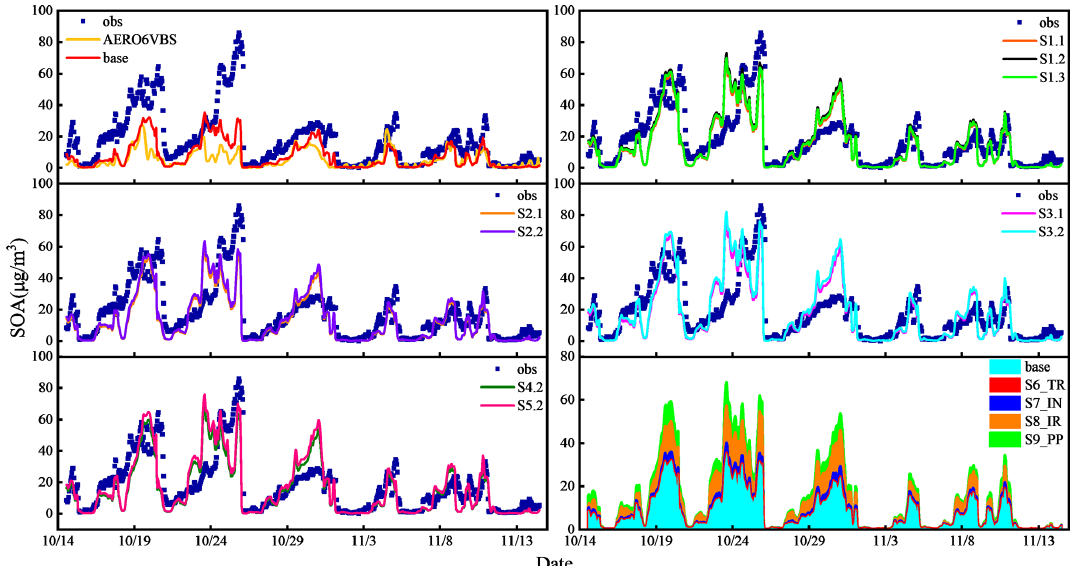
Figure 3. The observed and simulated hourly SOA concentrations during the episode from 14 October to 14 November 2014 at the Beijing site for the sensitivity cases, as summarized in Table